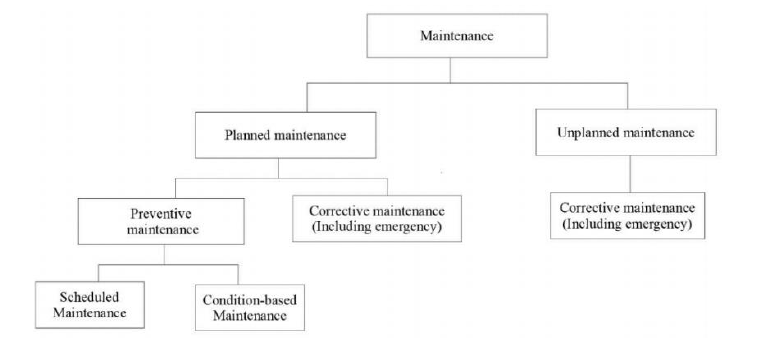
Figure 1: Types of maintenance (Chanter and Swallow,